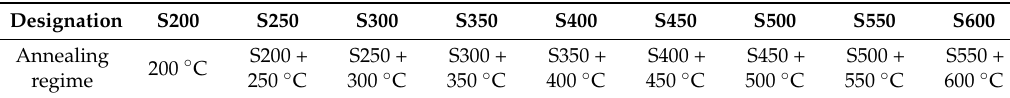
Table 1. Annealing regimes of Al-Fe-Si-Zr alloys.